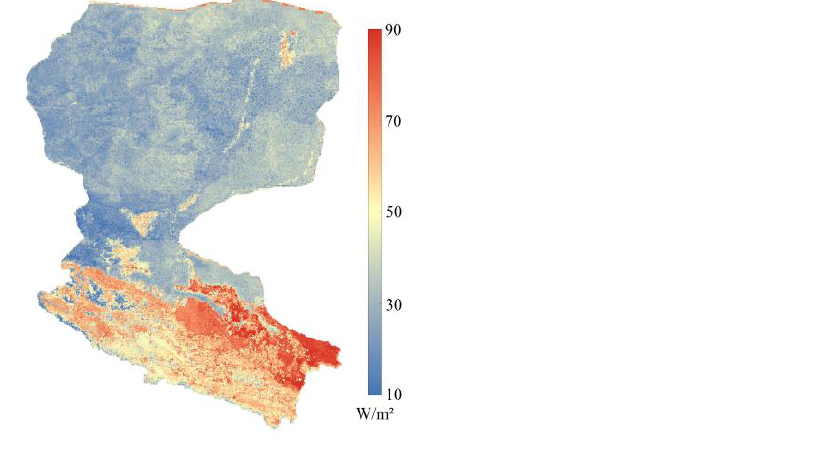
Figure 5. Spatial distribution of annual average latent heat flux over HRB in 2018.